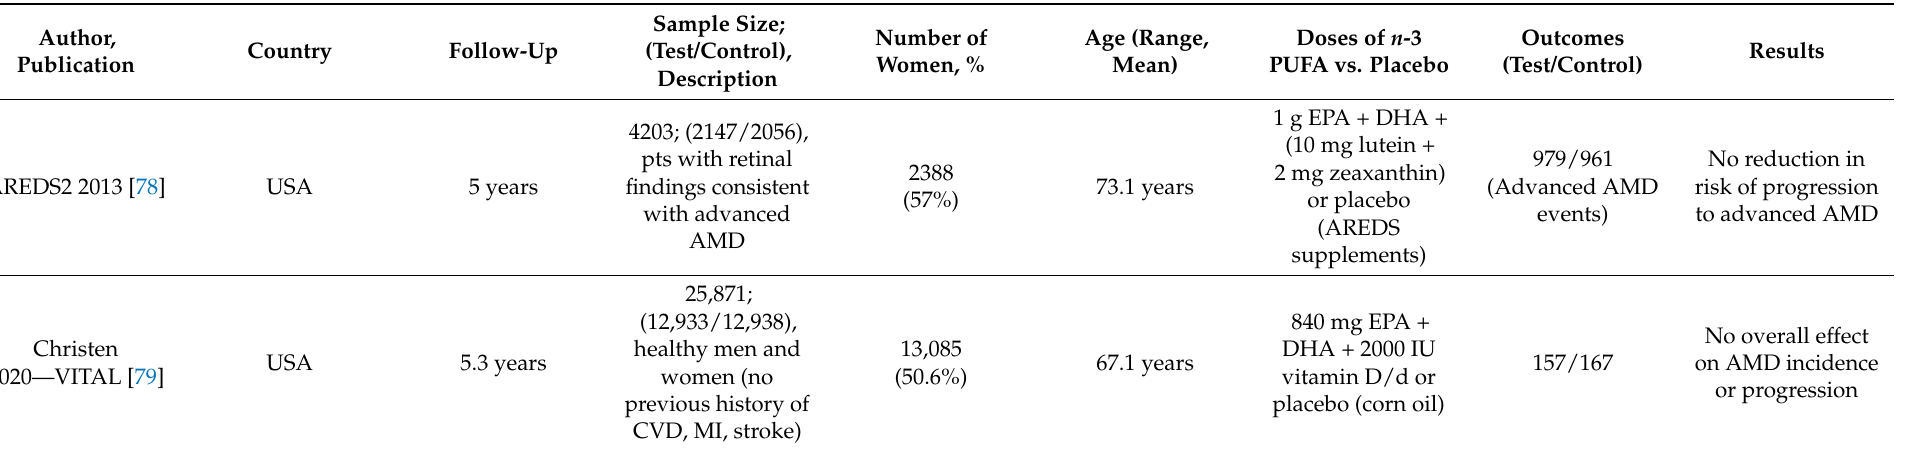
Table 4. Characteristics of RCTs studying the effects of n -3 PUFA on the incidence and progression of